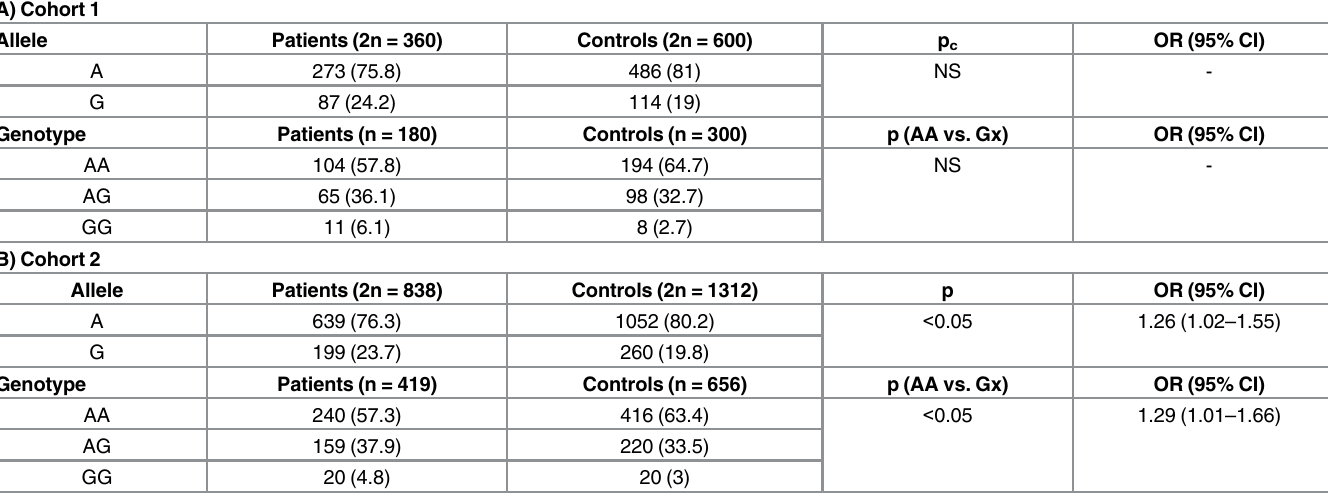
Table 1. A) IL17RA rs4819554 distribution in cohort 1. Statistical significance (p < 0.05) was lost when a Bonferroni correction was applied. B) IL17RA rs4819554 distribution in cohort